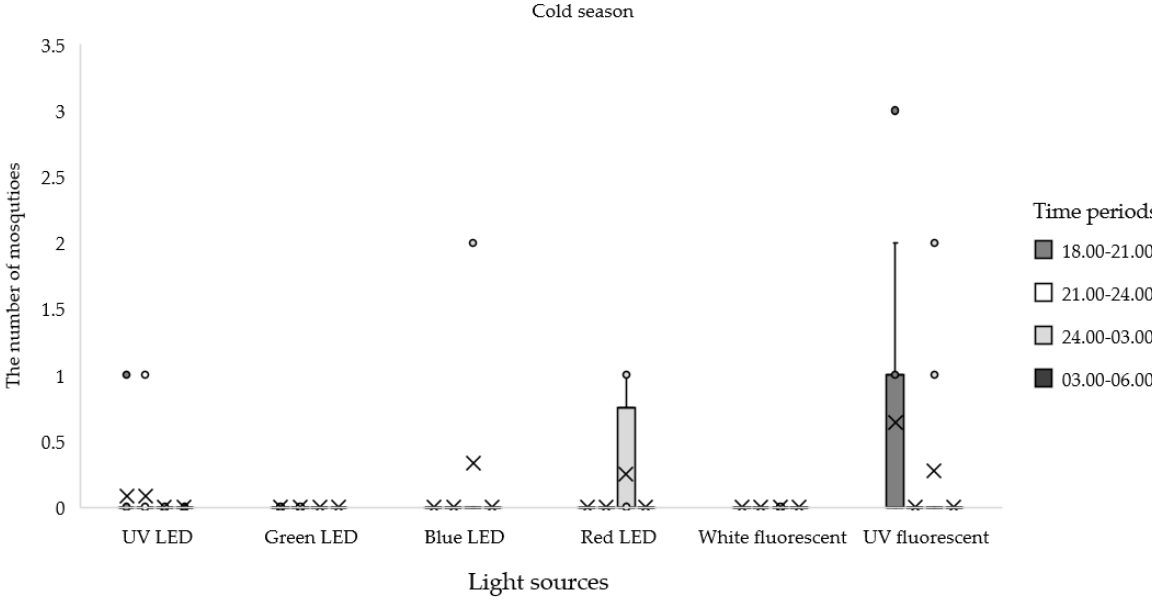
Figure 4. Mean numbers of Anopheles mosquitoes caught at different times of night by using different light traps during the cold season, November to February 2020.